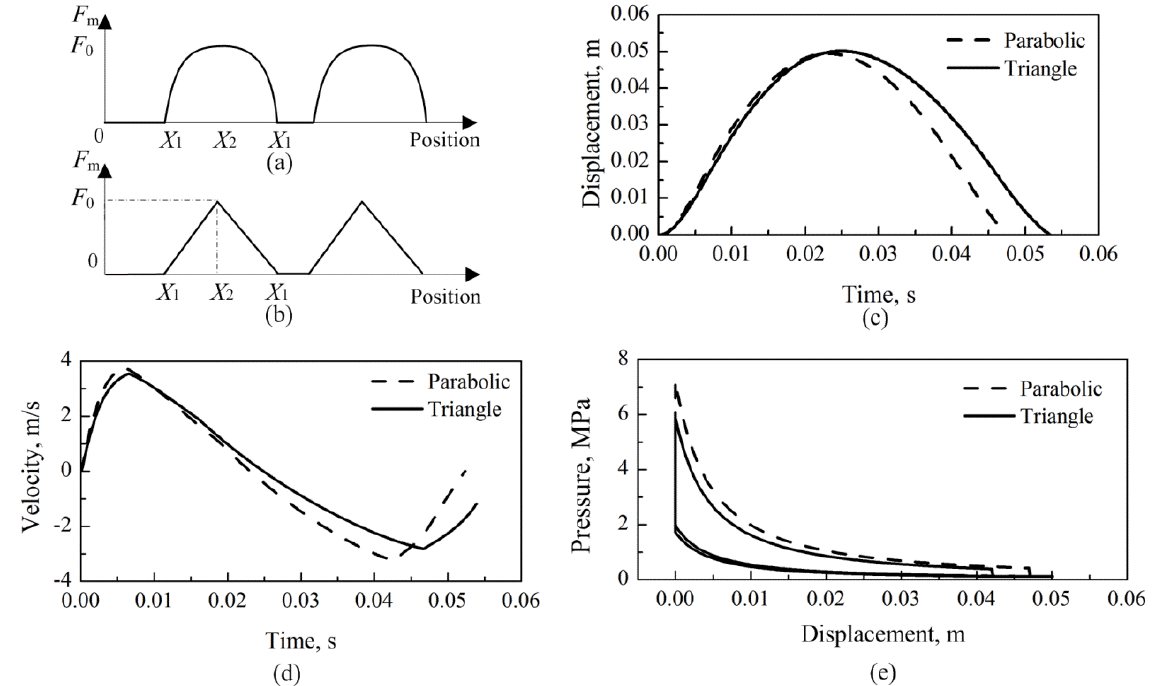
Figure 6. ( a ) Parabolic profile of motor rebound force; ( b ) Triangular profile of motor rebound force; ( c ) Displacement of two motor rebound force profiles vs. time; ( d ) Velocity of two motor rebound force profiles vs. time; ( e ) Pressure of two motor rebound force profiles vs.